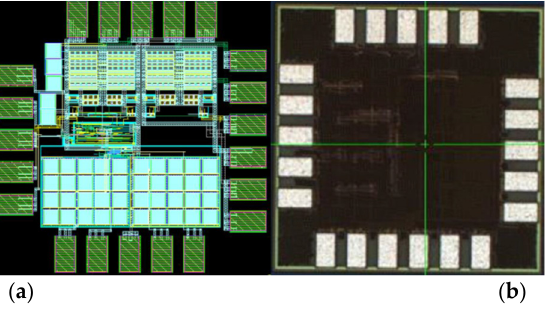
Figure 13. ( a ) The layout and ( b ) the die photo of the proposed rectifier.